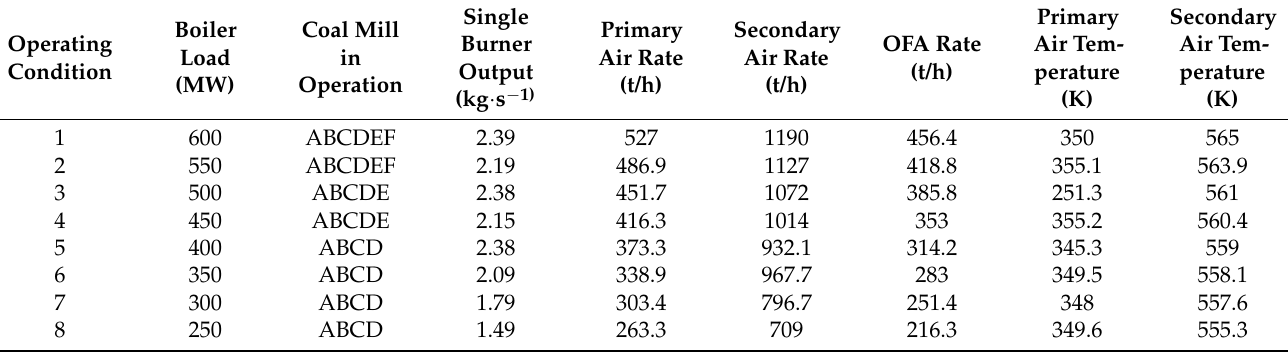
Table 3. Boiler operating parameters under 8 different boiler loads.